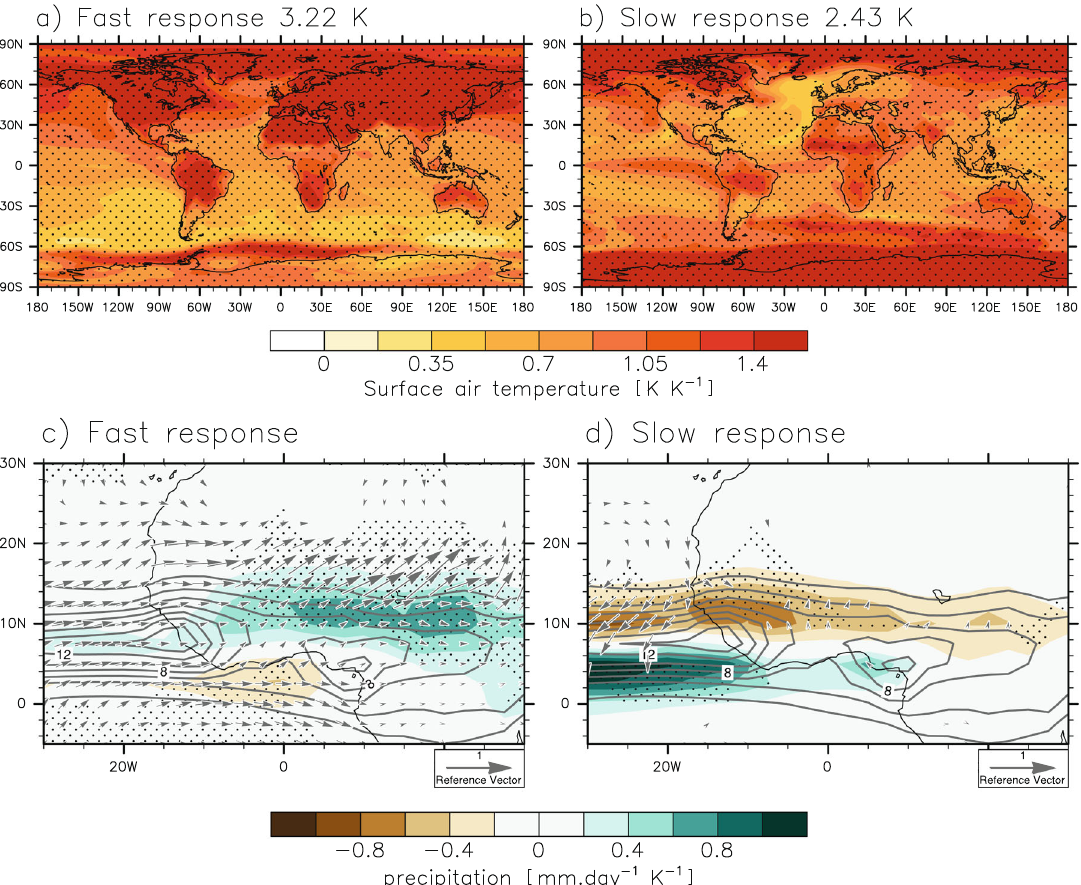
Fig. 1 Fast and slow responses to climate change. July – September mean temperature change (K. K − 1 ) due to the a fast and b slow response to abruptly quadrupling CO 2 , and displayed by degree of warming level (K) ( c , d ), as in a and b but for precipitation change (colour, mm day − 1 K − 1 ) and surface wind change (arrows, m s − 1 K − 1 ). On c and d , contours indicate the average JAS precipitation, de fi ned from pre-industrial control simulations. Stippling represents the grid-points where at least 80% of the models agree with the sign of the ensemble mean. 26 models were